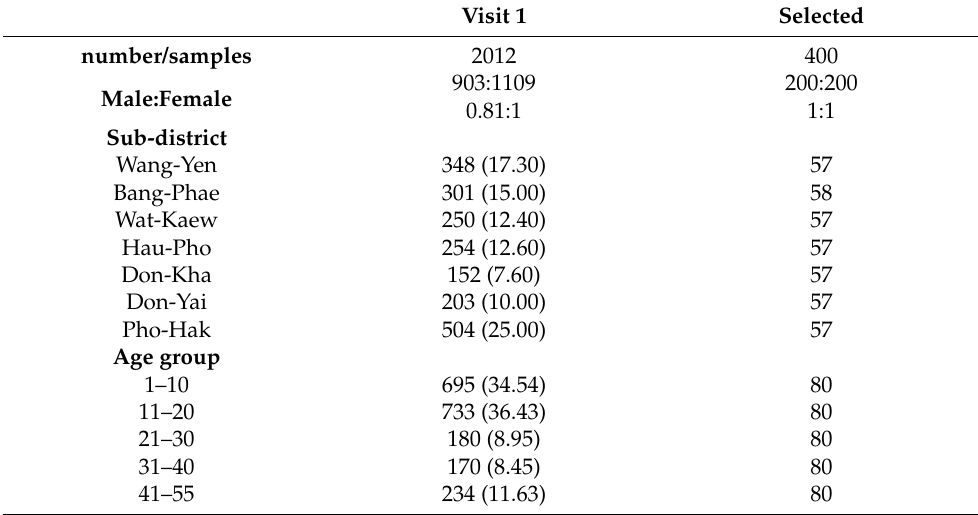
Table 1. Demographic characteristic of subjects [ n